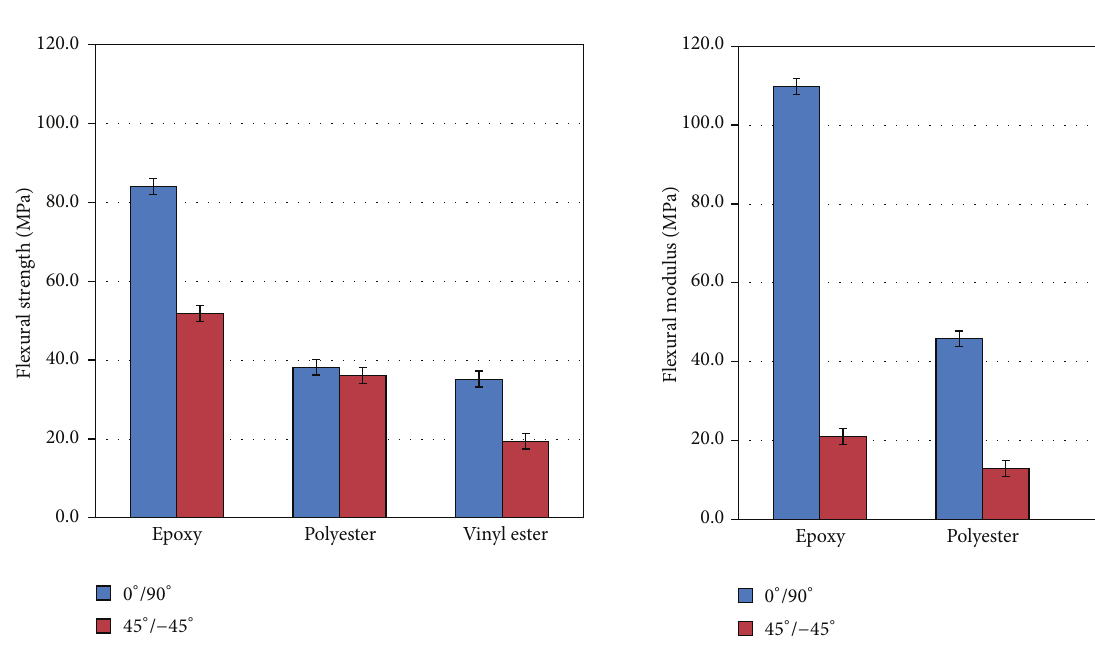
Figure 6: Flexural modulus of three composites at 0 ∘ /90 ∘ and 45 ∘ / − 45 ∘ orientation.